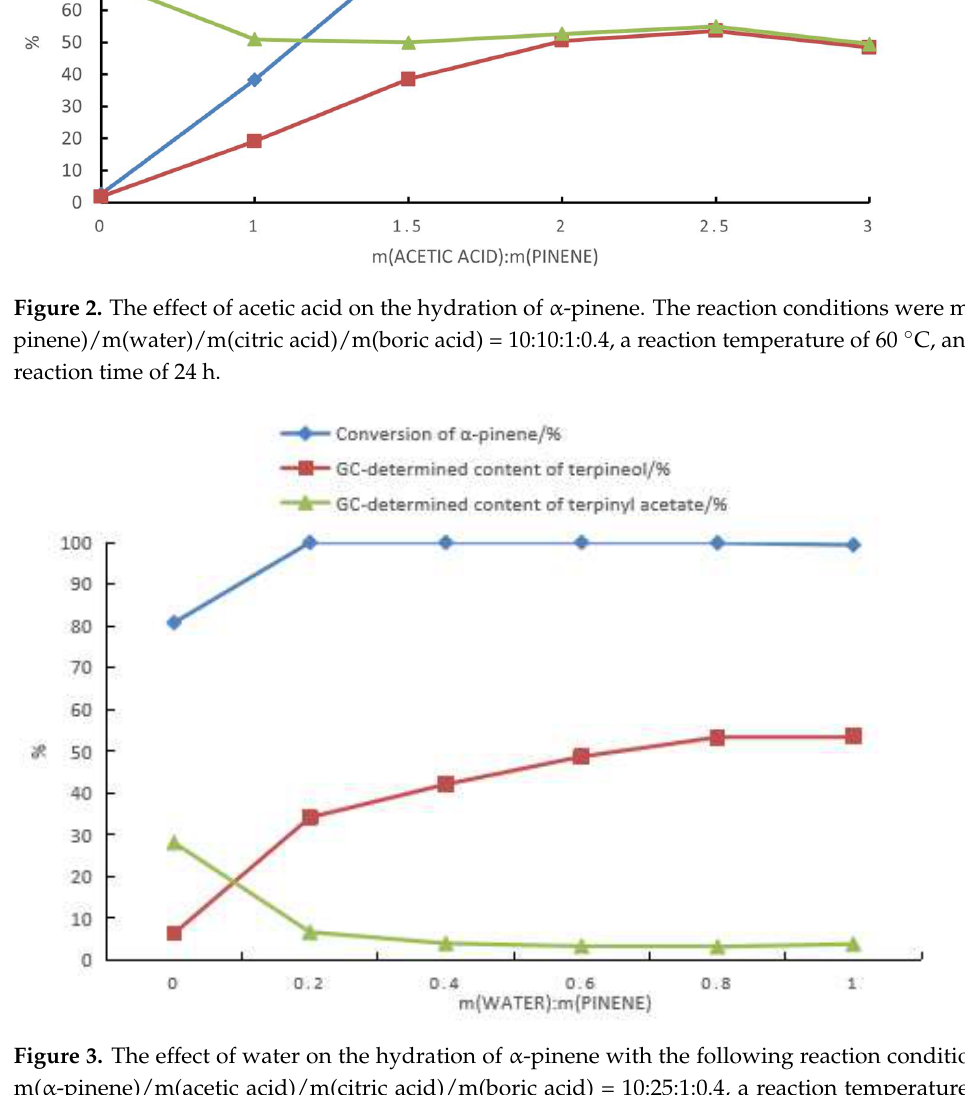
°C, and a reaction time of 24 h. 60 ◦ C, and a reaction time of 24